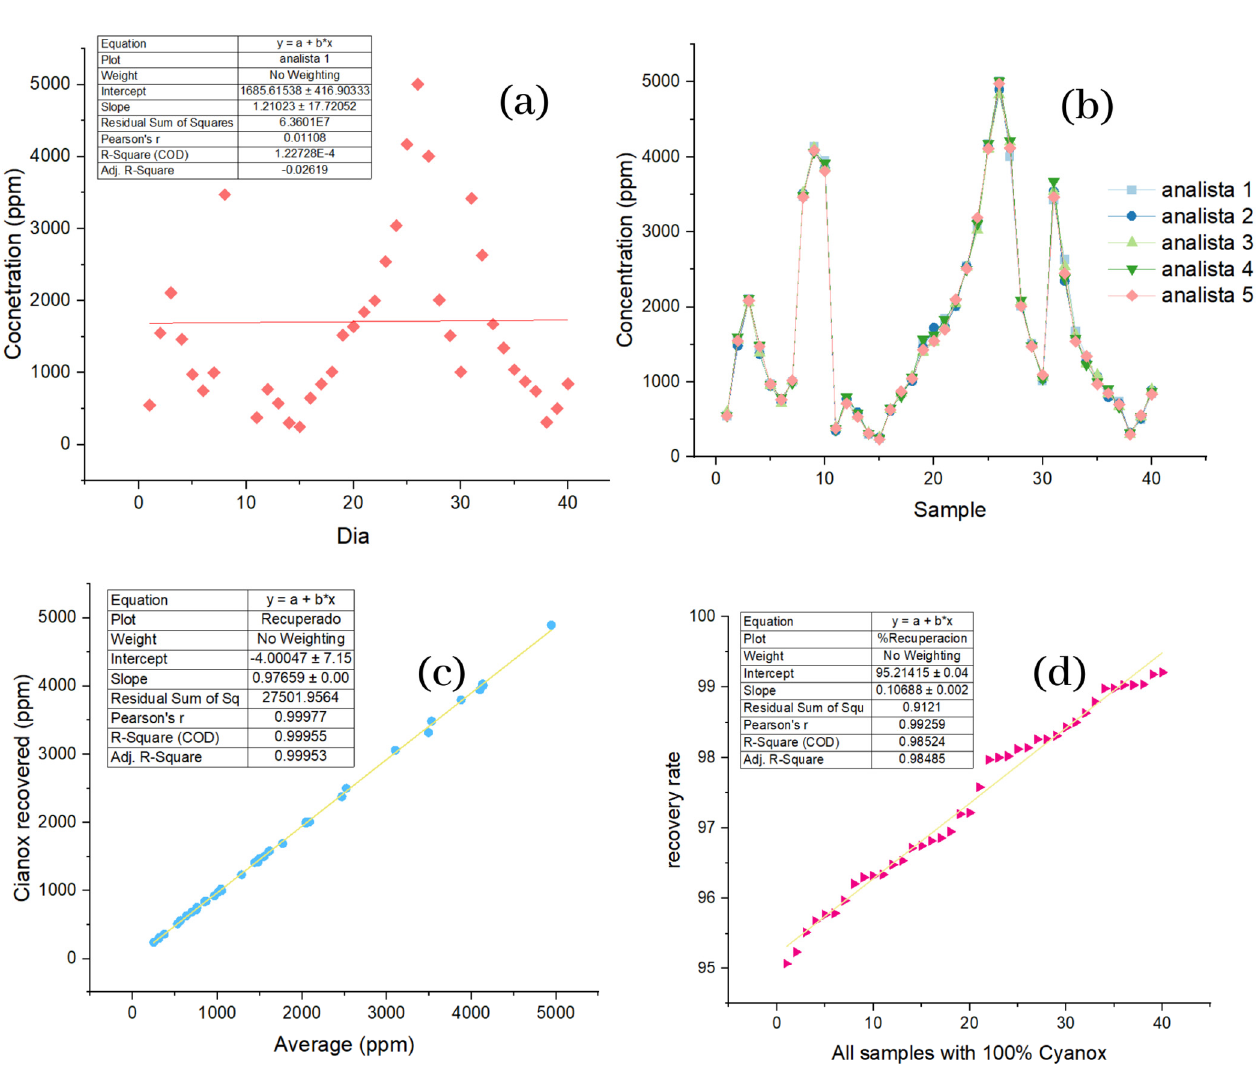
Figure 4. ( a ) Distribution of concentration data per day for samples; ( b ) repeatability of the data by analysts per sample; ( c ) analyte recovery based on mean sample concentrations; ( d ) percentage recovery of analyte based on 100% analyte per